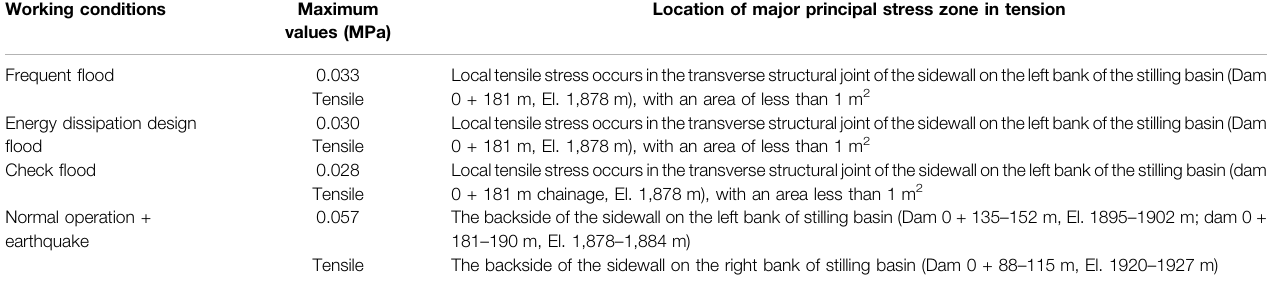
TABLE 4 | Numerical modelling results of major principal stress of stilling basin under 4 types of working conditions.